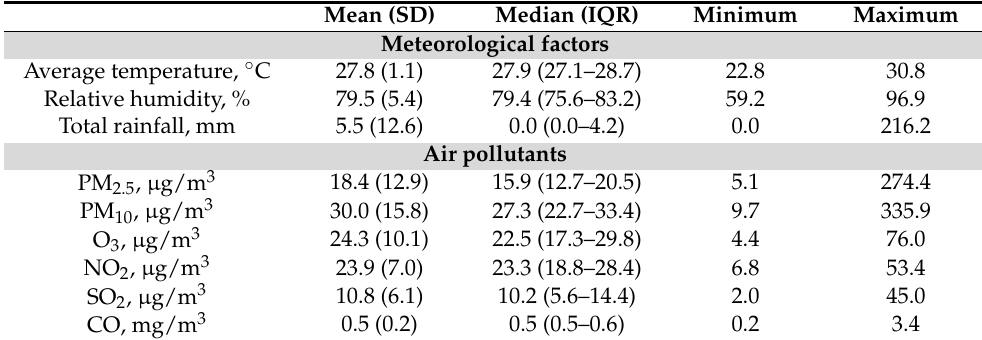
Table 2. Descriptive summary of the meteorological factors and air pollutants in 2009–2018